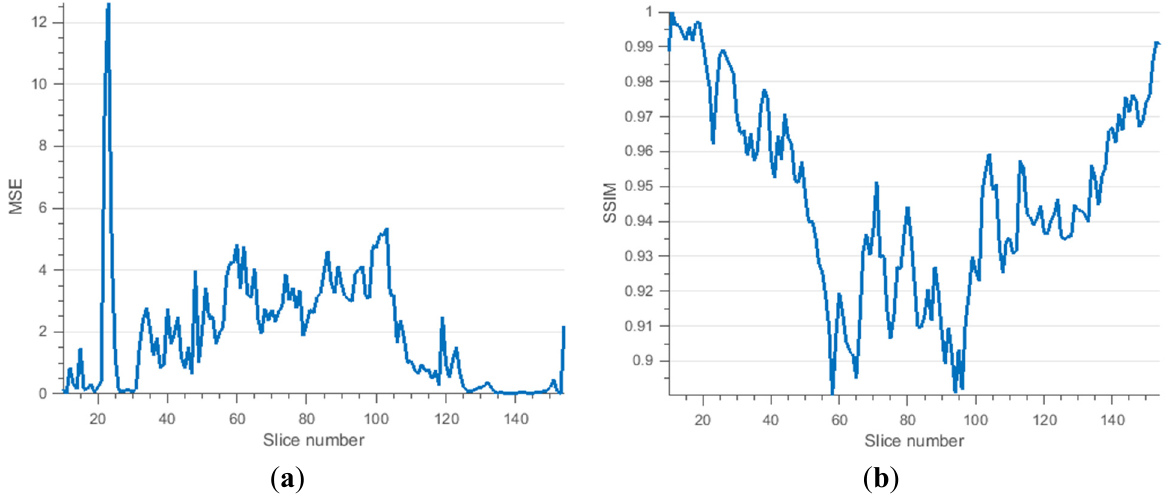
Figure 13. ( a ) A comparison of MSE of the estimated fuzzy label mask to the ground truth for the moderate brain data. The spike at slice 23 is due to a segmentation failure of